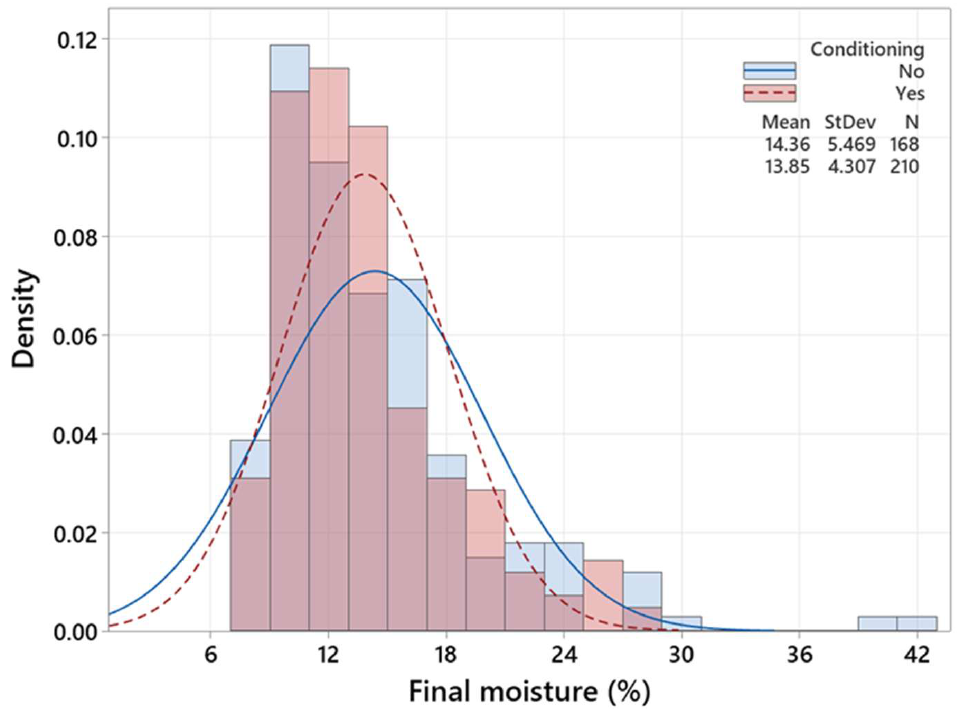
Figure 5. Histogram and distribution curves of the M f in the existence and nonexistence of the conditioning treatment.